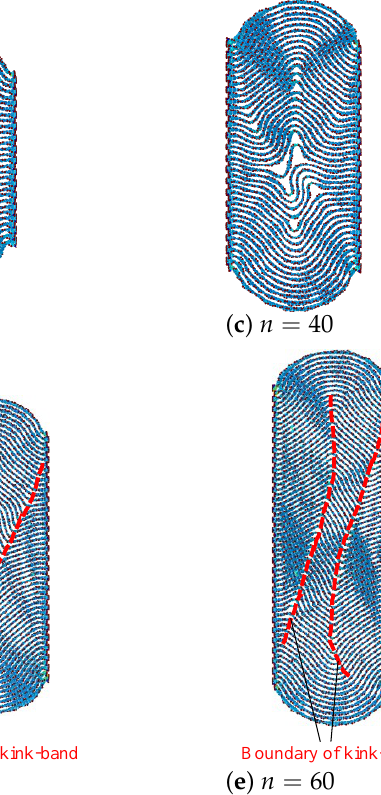
Figure 5. Deformation of armchair graphite under compression ( ε =